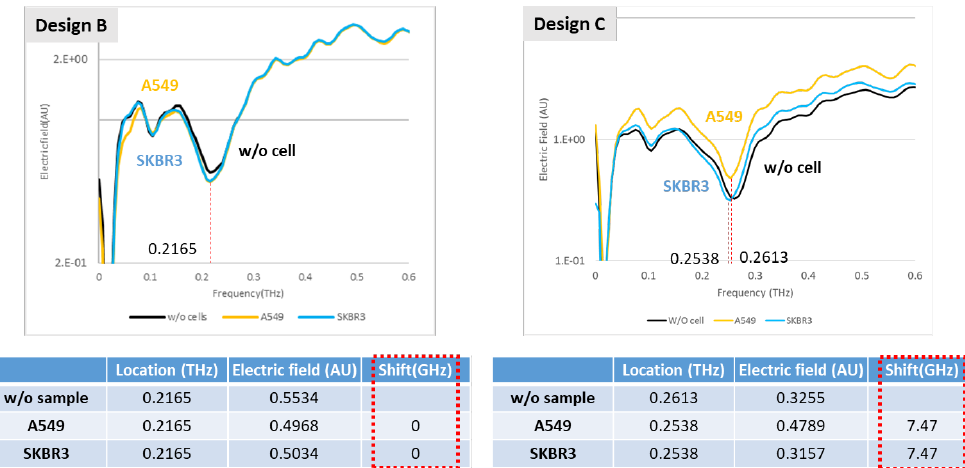
Figure 8. Detection of cancer cell on XPS of two designs; the red shift has extent 7.47 GHz in design C for both cells.